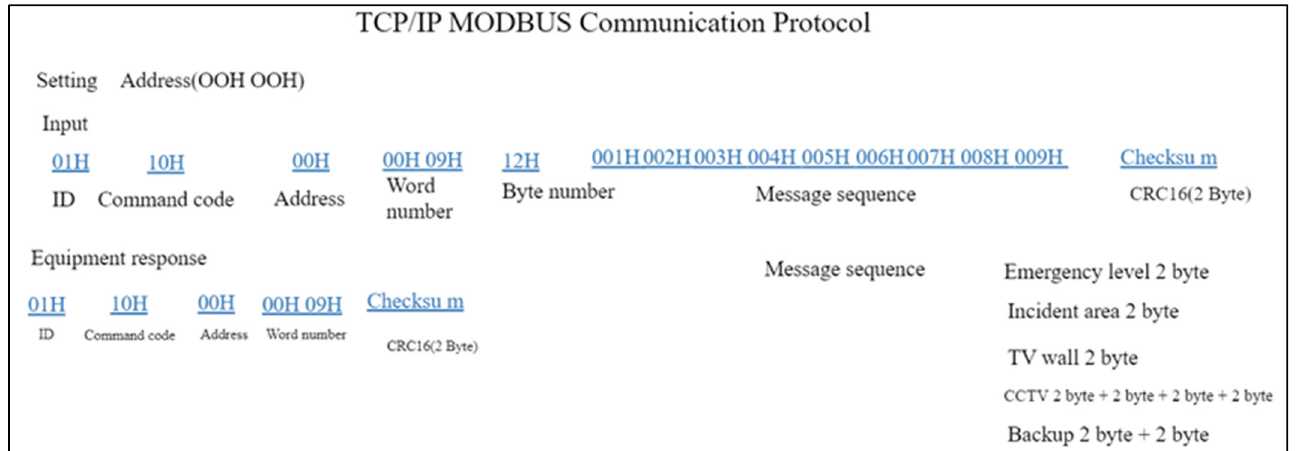
Figure 3. System interface diagram. (Source: Taipei Main Station Intelligent Joint Disaster Prevention Center, 2022).